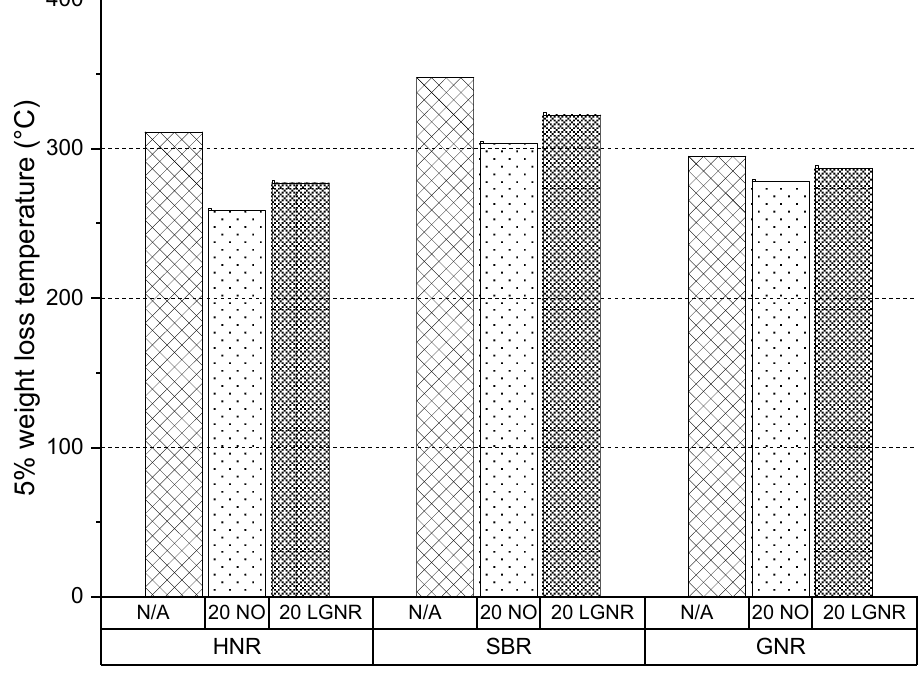
Figure 6. The 5% weight-loss temperature of HNR, SBR and GNR composites made with or without processing aids at 5% weight loss. N/A: rubber compounds without processing aids; 20 NO: rubber compounds with 20 phr naphthenic oil; 20 LGNR: rubber compounds with 20 phr liquid guayule natural rubber.